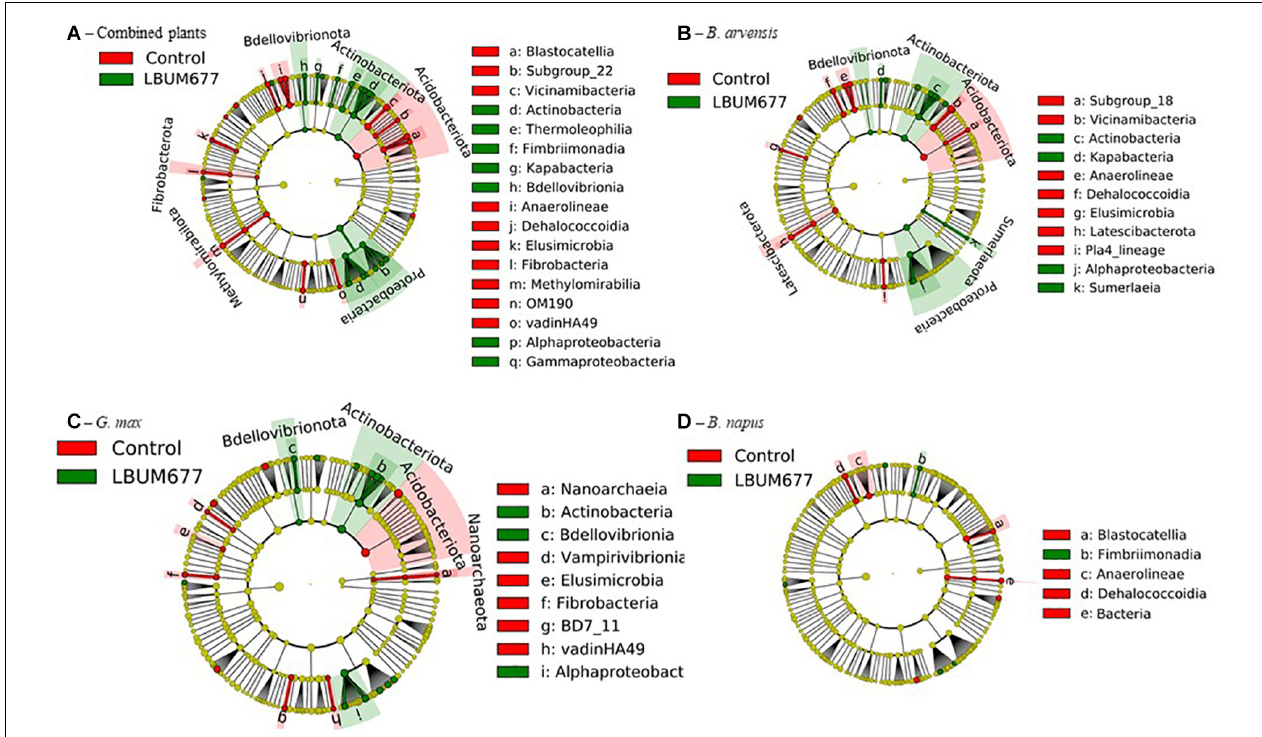
FIGURE 7 | Cladograms representing the differentially abundant taxa between control samples and LBUM677-inoculated samples. (A) the combination of all three plant species, (B) B. arvensis plants, (C) G. max plants and (D) B. napus plants. Red indicates an increased abundance in control samples while green indicates an increase in LBUM677-treated samples. Differentially abundant sequences were determined using the non-parametric factorial Kruskal-Wallis sum-rank test. A subsequent Linear Discriminant Analysis was used to estimate the effect size of each differentially abundant